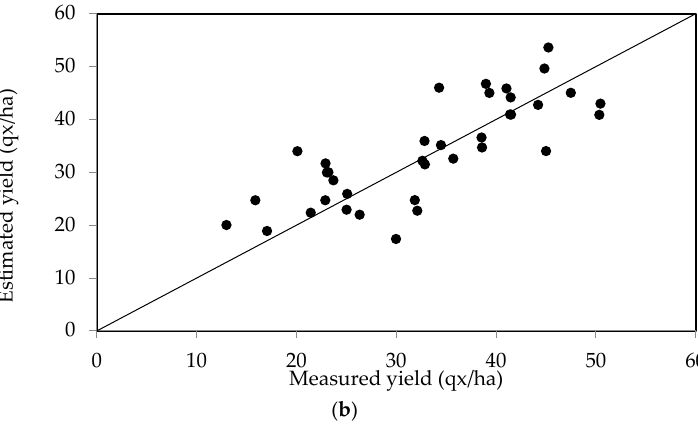
Figure 10. ( a ) Relationship between the grain yields of irrigated cereals and LAI during the period of maximum growth; ( b ) Measured grain yields in irrigated test plots compared with yield estimates, computed using the maximum growth period LAI, over two crop years.